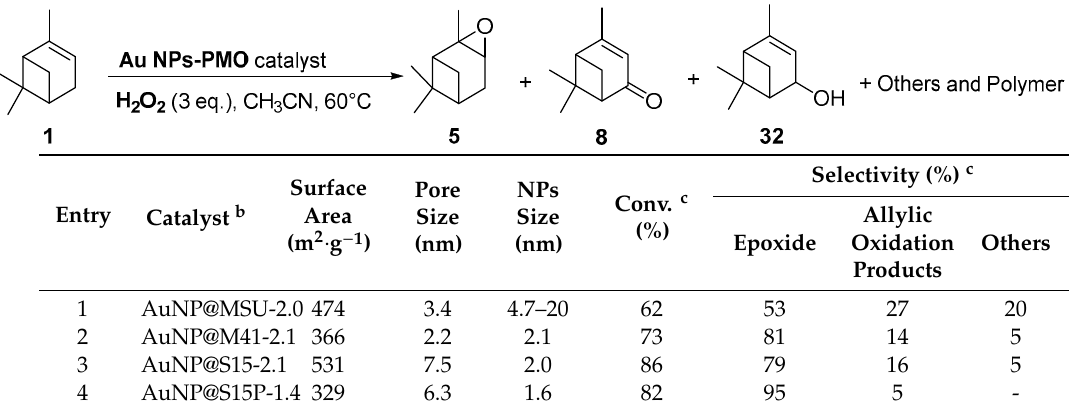
Table 4. Oxidation of α -pinene 1 catalyzed by gold nanoparticles supported on periodic mesoporous organosilicas a (adapted from reference [30]).